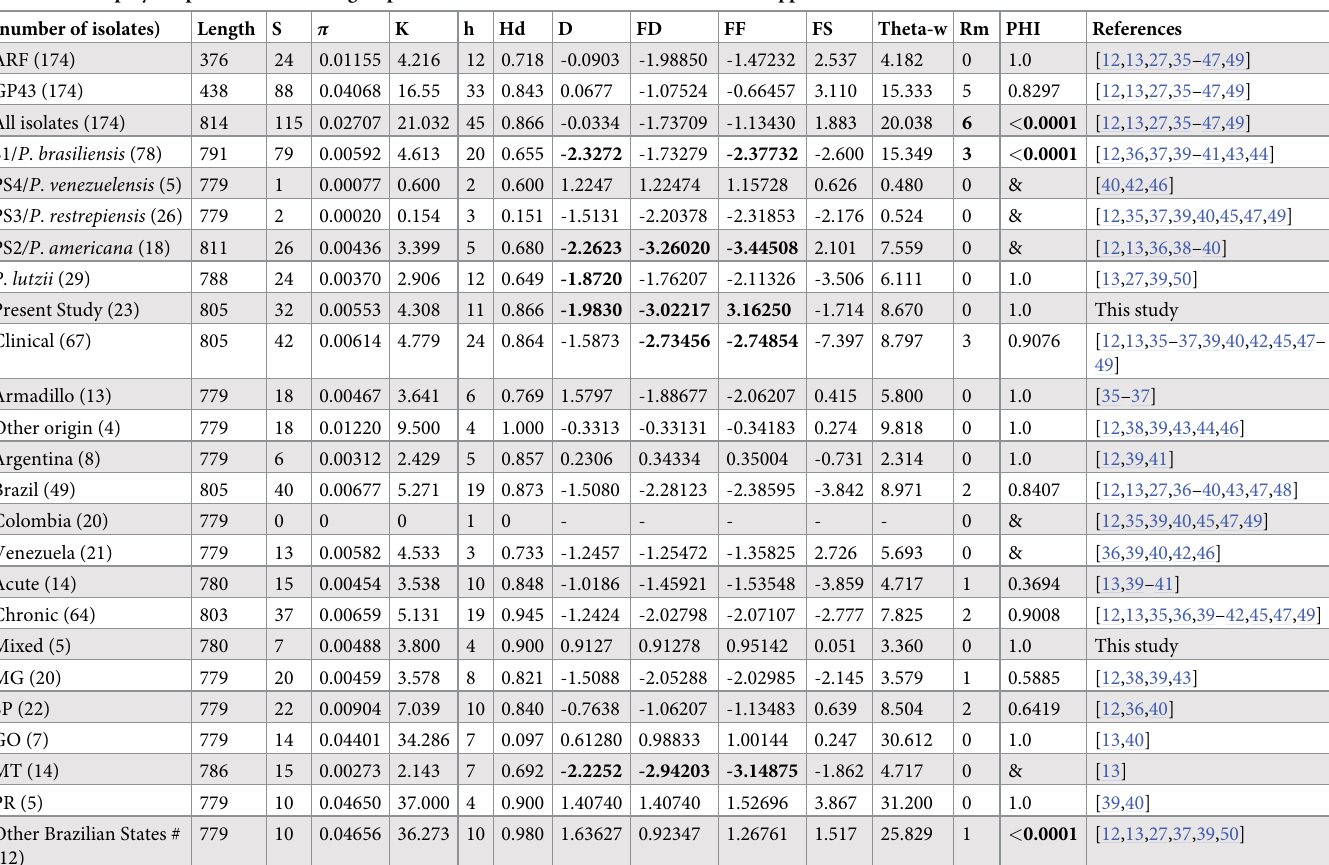
Table 2. DNA polymorphisms in different groups to loci GP43 + ARF in 174 Paracoccidioides spp.